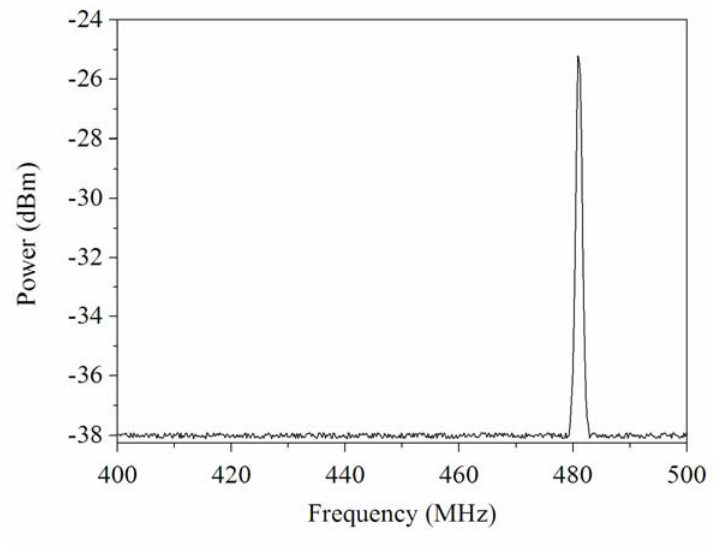
Figure 10. Frequency response of the pressure sensor at zero